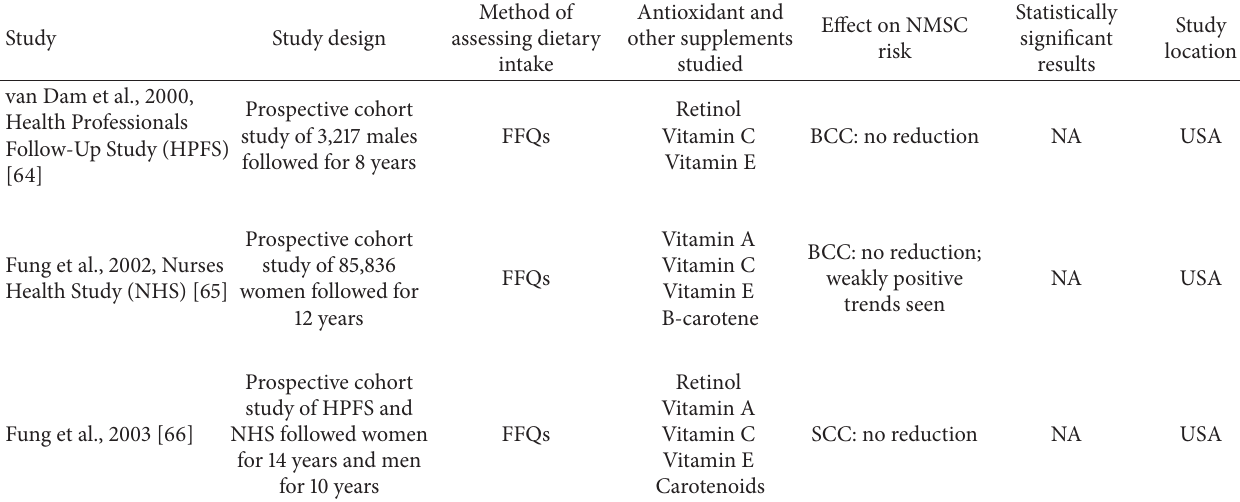
Table 2: Observational studies of dietary intake via supplements combined with food and NMSC